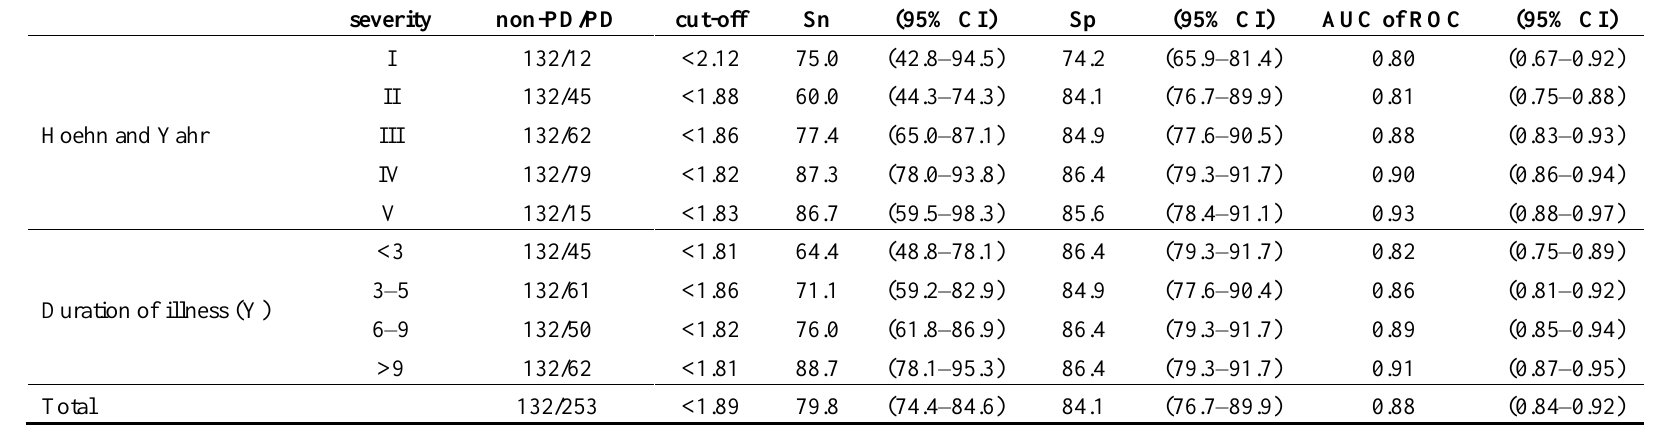
Table 2. ( A ) Diagnostic significance of early H/M of diagnosis of PD.